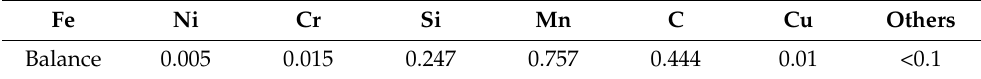
Table 4. Chemical composition of AISI 1045 (wt %) (cited mill test certificate for the used AISI 1045). Fe Ni Cr Si Mn C Cu Others Balance 0.005 0.015 0.247 <0.1